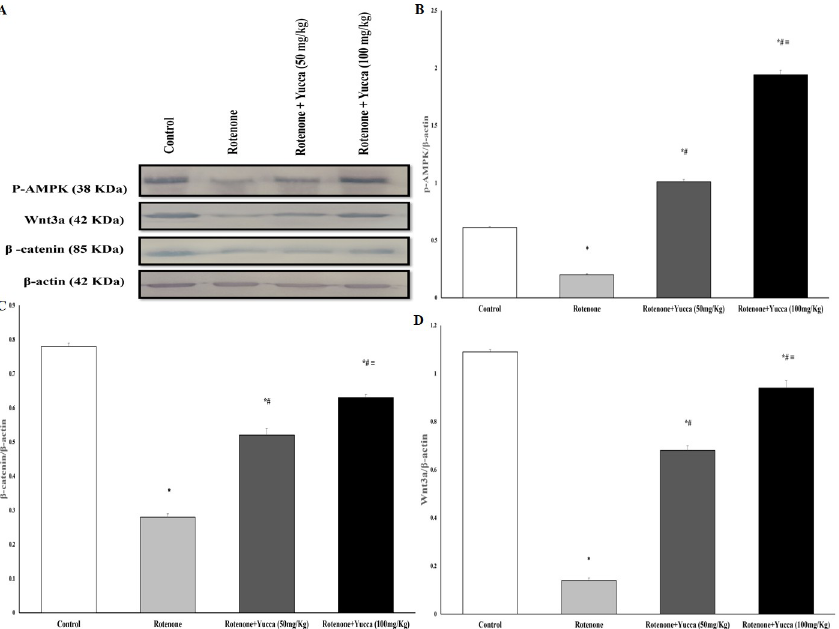
Fig 8. ( A ) The protein expression of p-AMPK, β -catenin and Wnt3a determined by western blot analysis. ( B-D ): the relative band intensities of p-AMPK, β -catenin and Wnt3a adjusted to the expression of β -actin. Co-treatment of yucca extract with rotenone increased protein expression of (B) p-AMPK, ( C ) β -catenin ( D ) Wnt3a. Data are represented as the mean ± SEM of eight animals in each group. ( � ) Significantly differs ( P < 0.05) compared to control group; (#) significantly differs ( P < 0.05) compared to rotenone alone treated group; ( � ) significantly differs ( P < 0.05) compared to rotenone + yucca (50mg/kg) treated group.